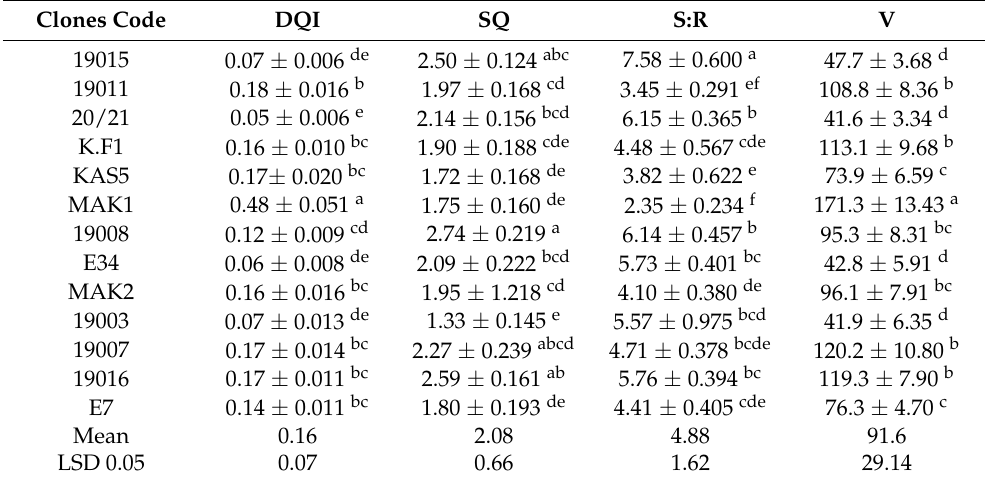
Table 3. Variation in quality indexes of 13 selected Melia volkensii clones after